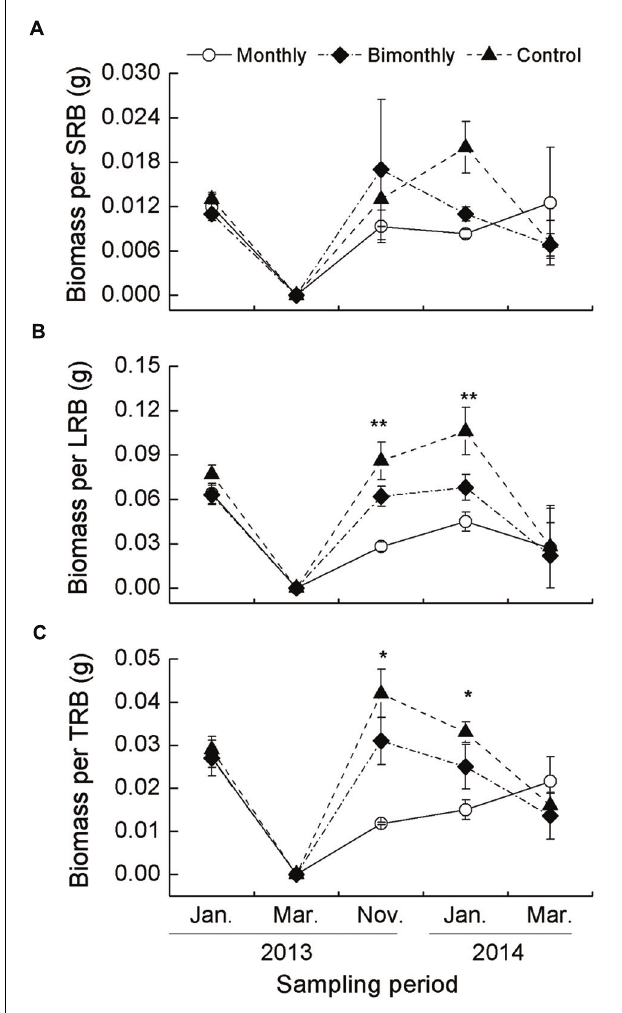
FIGURE 5 | Biomass per short rhizome bud (SRB, A), long rhizome bud (LRB, B), and total rhizome bud (TRB, C) C. brevicuspis populations for three defoliation frequencies, January 2013–March 2014. The data are expressed as the mean ± standard error (SE). ∗ p < 0.05, ∗∗ p <